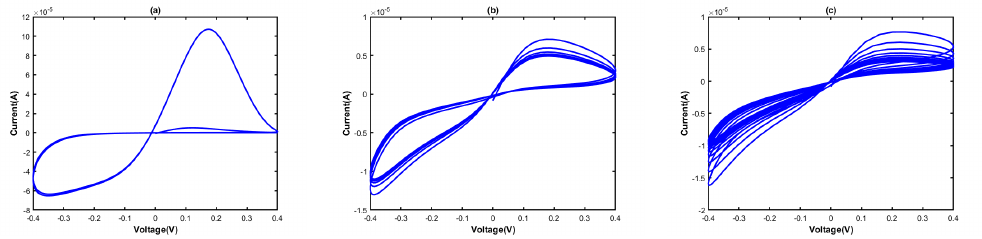
Figure 5. Voltage − current curves for 16 nm, when frequency is ( a ) 2 kHz, ( b ) 10 kHz, and ( c ) 20 kHz.